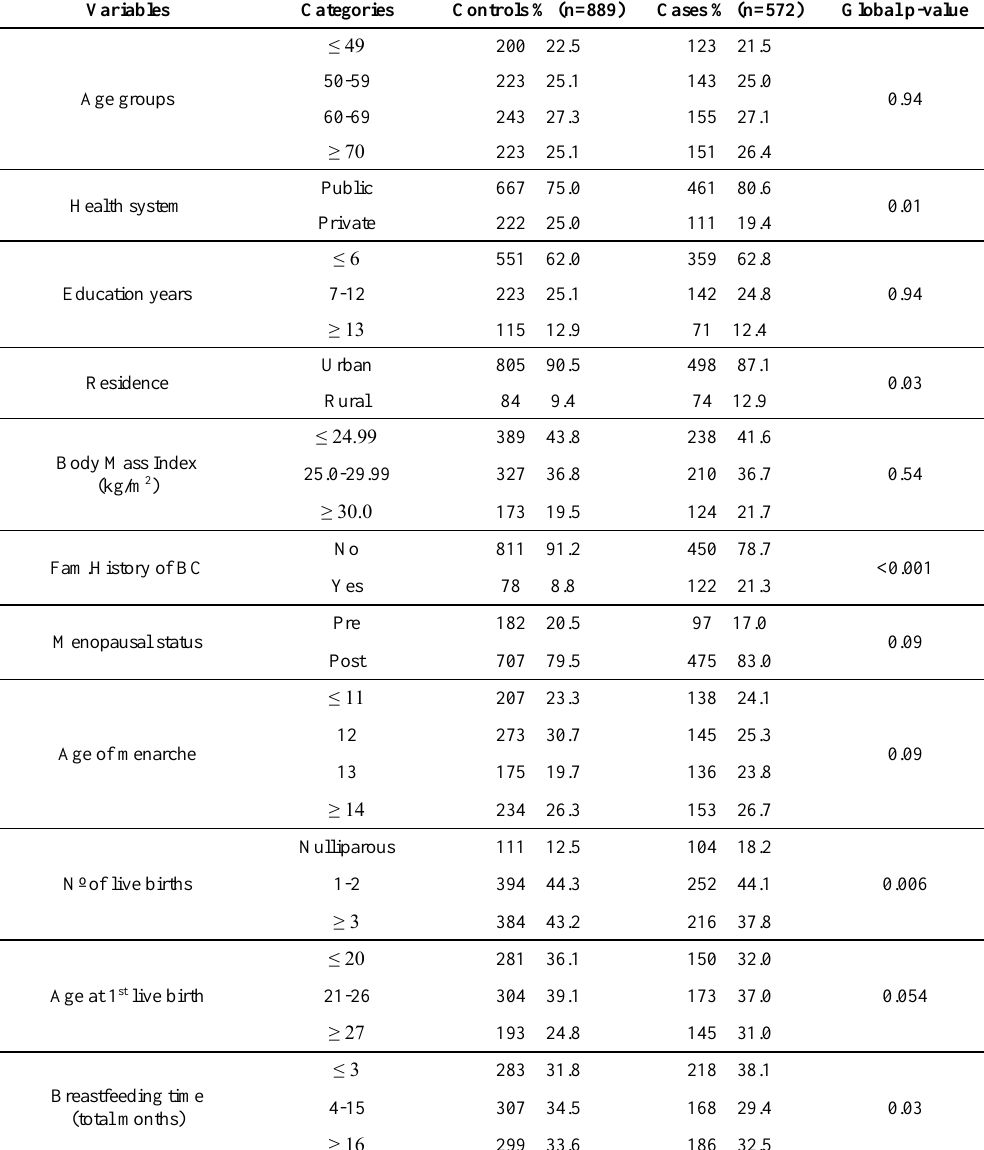
Table 1. Distribution of sociodemographic and selected reproductive variables in cases and